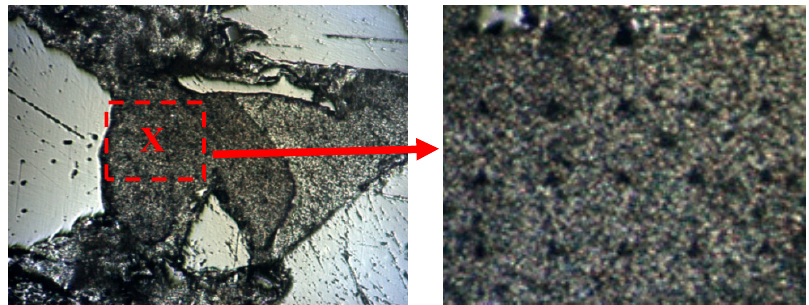
Figure 1. Indentation sites for Set 1 (marked with X) .